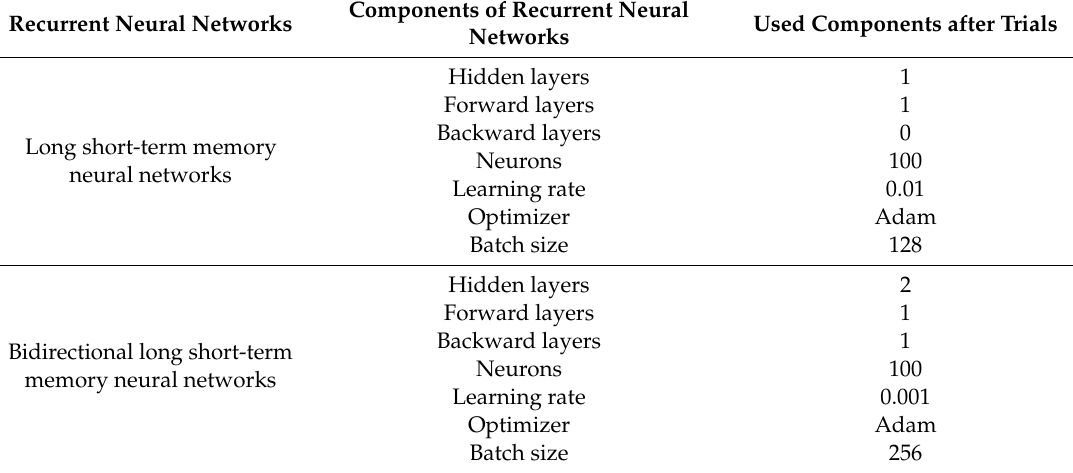
Table1. Thestructuresofrecurrentneuralnetworksforanalysisofthisstudyfinalizedafterseveraltrials. Table 1. The structures of recurrent neural networks for analysis of this study finalized after several Recurrent Neural trials.